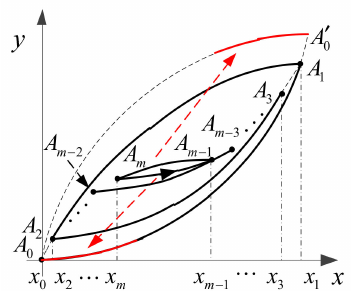
Figure 3. Madelung’s rules: (1) Any hysteresis curve beginning from a turning point is uniquely determined by the coordinates of this point. (2) If any point on the hysteresis curve becomes a new turning point, then the new curve goes back to the previous turning point. (3) If the hysteresis (cid:95) (cid:95) A 2 A 1 is continued beyond A 1 , it is transferred to A 0 A (cid:48) 0 as if the hysteresis trajectory on the curve loop A 1 A 2 − A 2 A 1 does not exist at